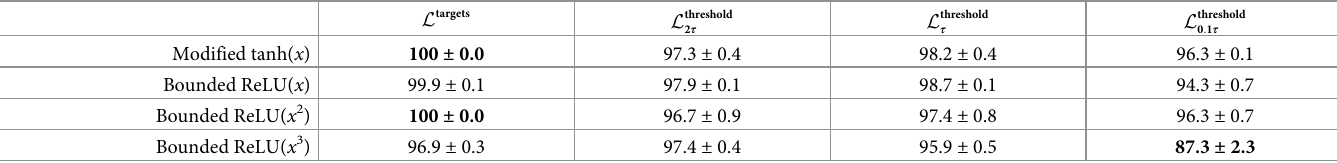
Table 1. Accuracy for different training methods.